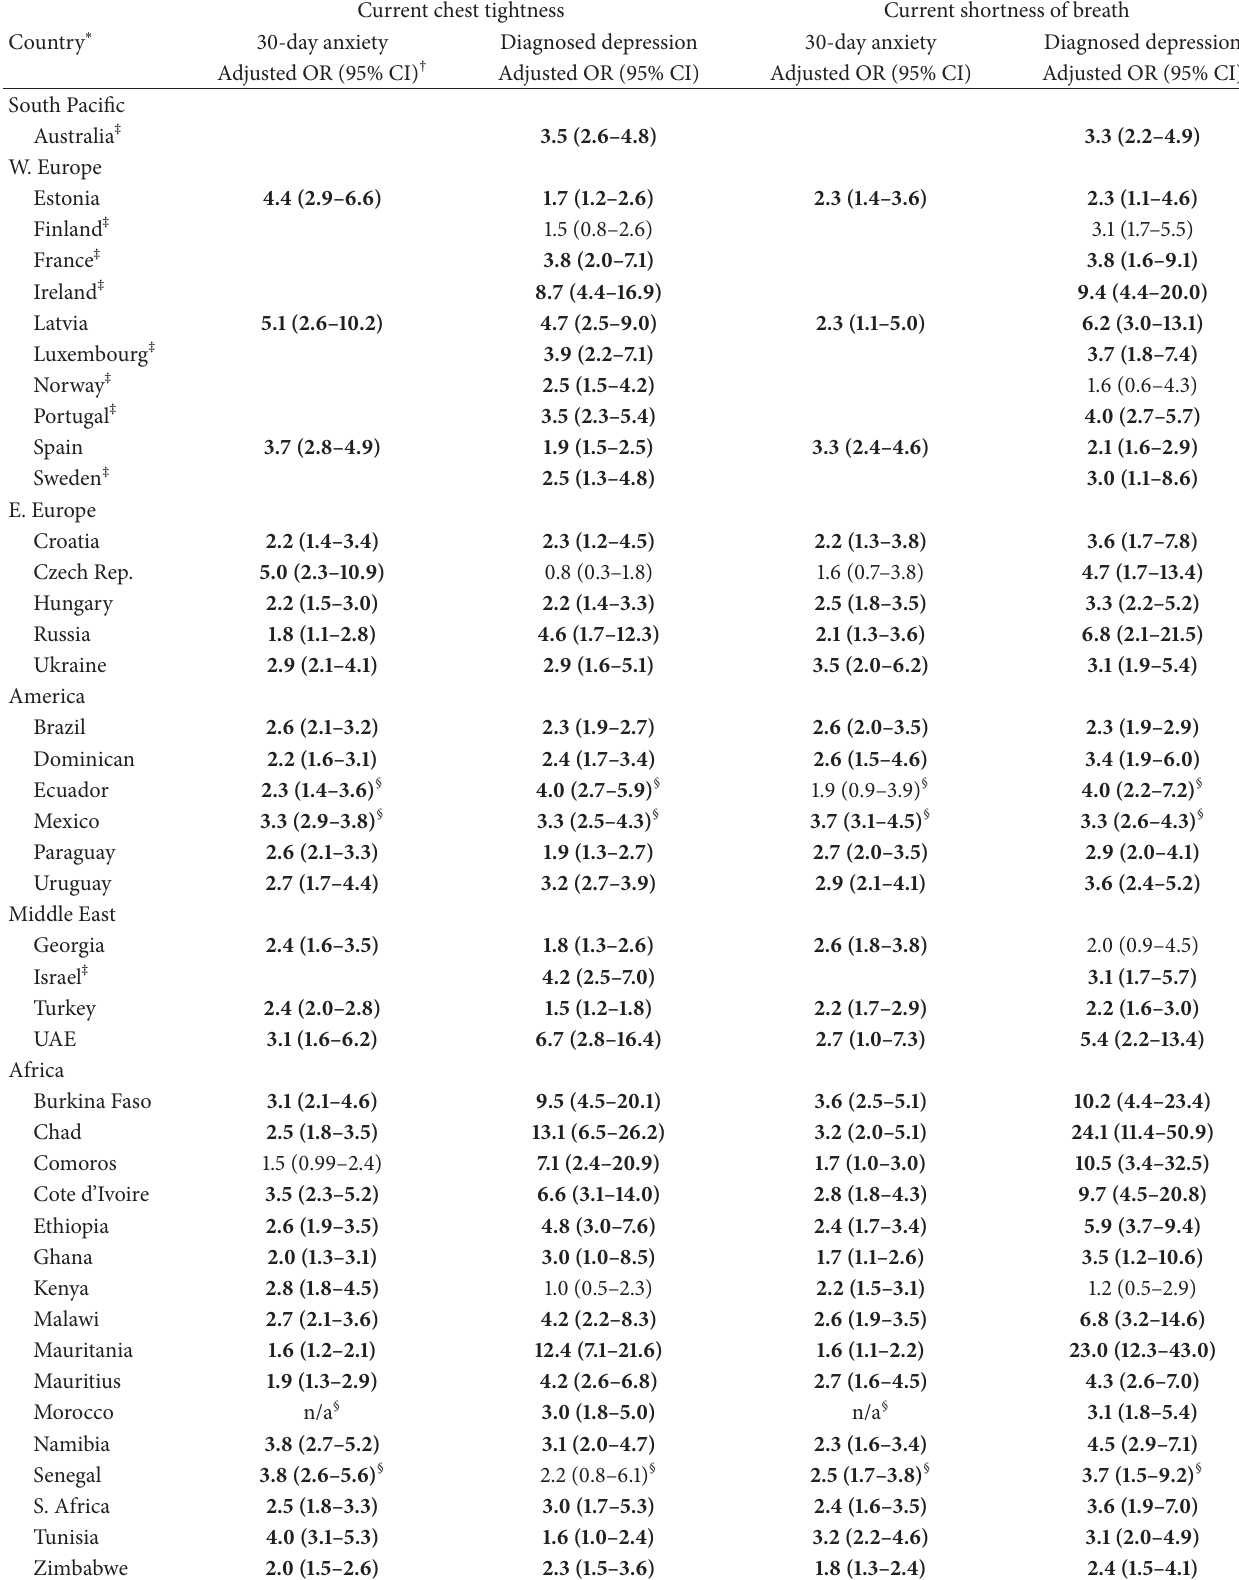
Table2:Oddsratiosand95%confidentintervalsofdiagnoseddepressionand30-dayanxietyoncurrentchesttightnessandcurrentshortness of breath in adults by region and